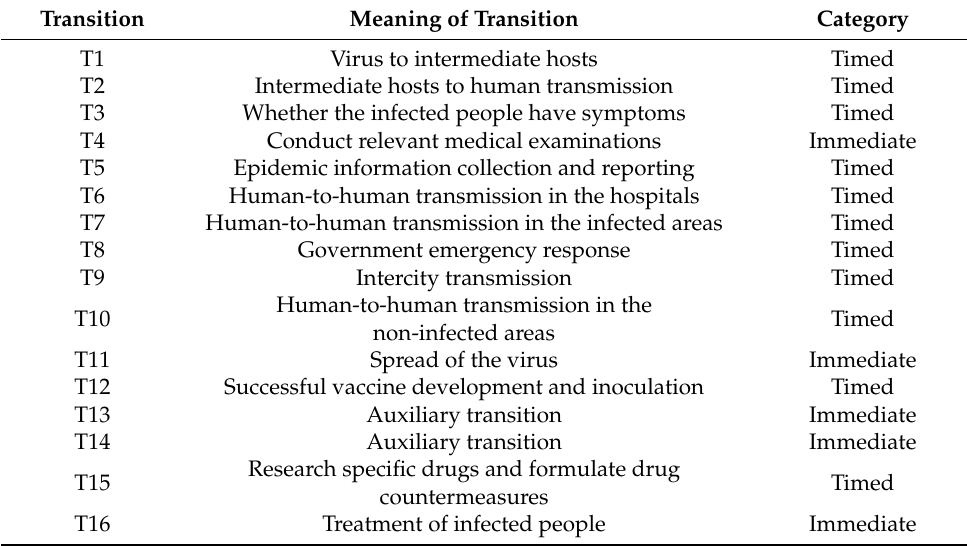
Table 2. Meanings of transitions of the GSPN model in Figure